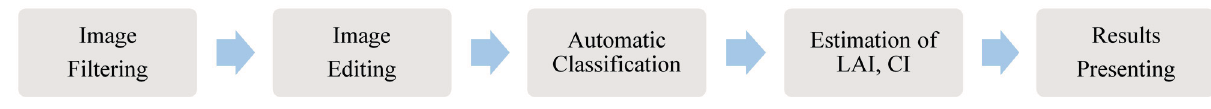
Figure 9. Flow of the collection of growth parameters from canopy